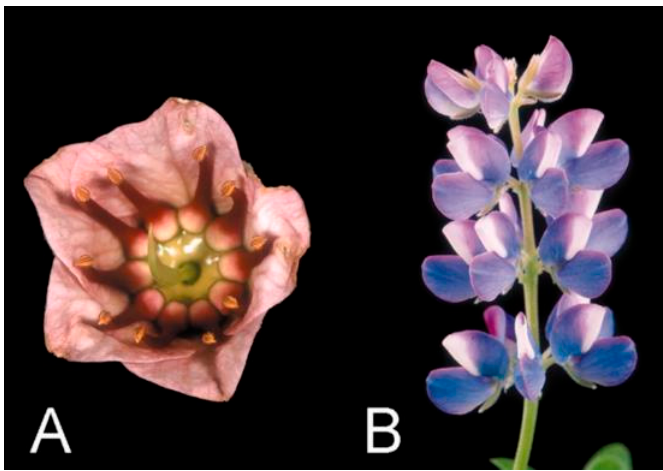
Figure 2. Flowers of Cadia purpurea and Lupinus nanus [60] . ( A ) Flower of Cadia purpurea with actinomorphic corolla. ( B ) Flowers of Lupinus nanus with zygomorphic corolla. Reprinted with permission from Ref. [60]. Copyright © 2023, Oxford University Press.